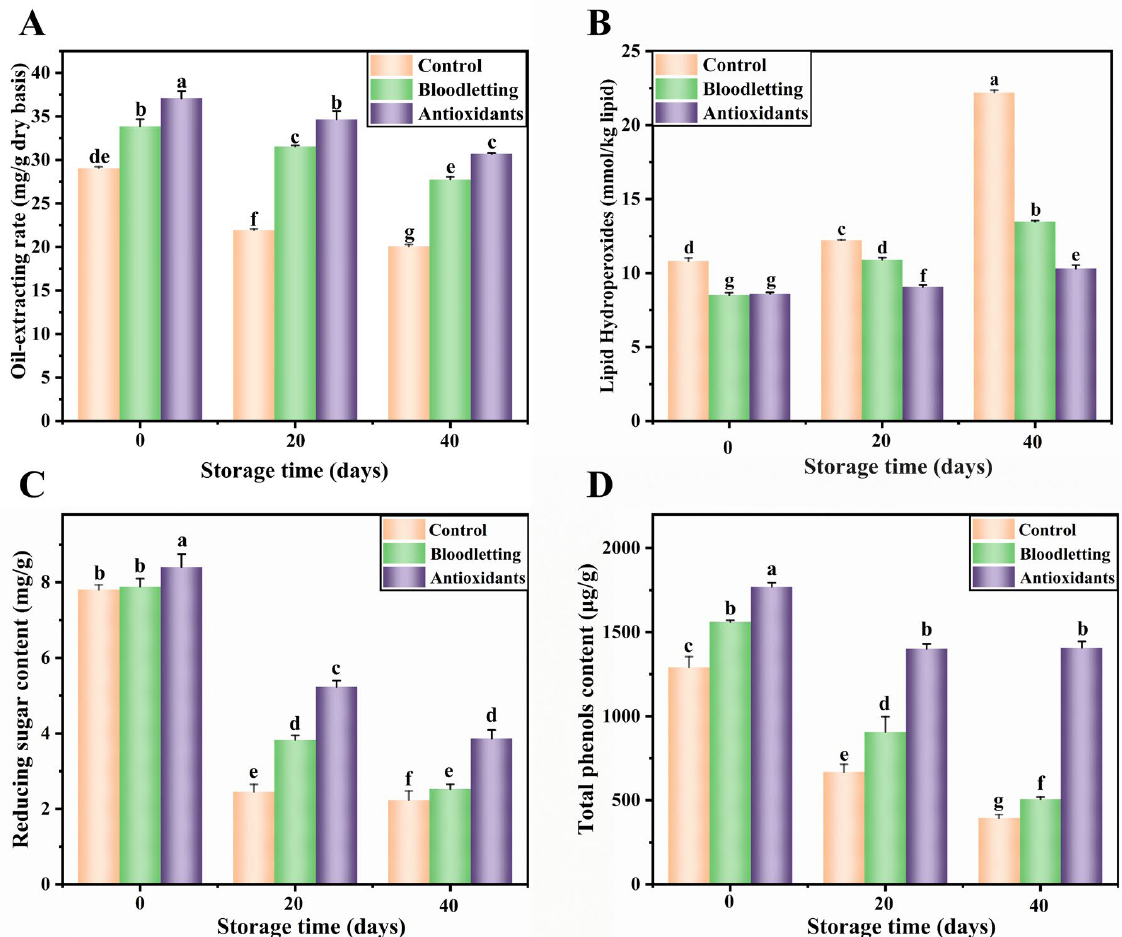
Figure 2. Changes in oil-extraction rate ( A ), lipid hydroperoxides ( B ), reducing sugar content ( C ) and total phenols content ( D ) of abalone muscle during storage. Values of different groups with different lower-case letters are significantly different at p < 0.05.